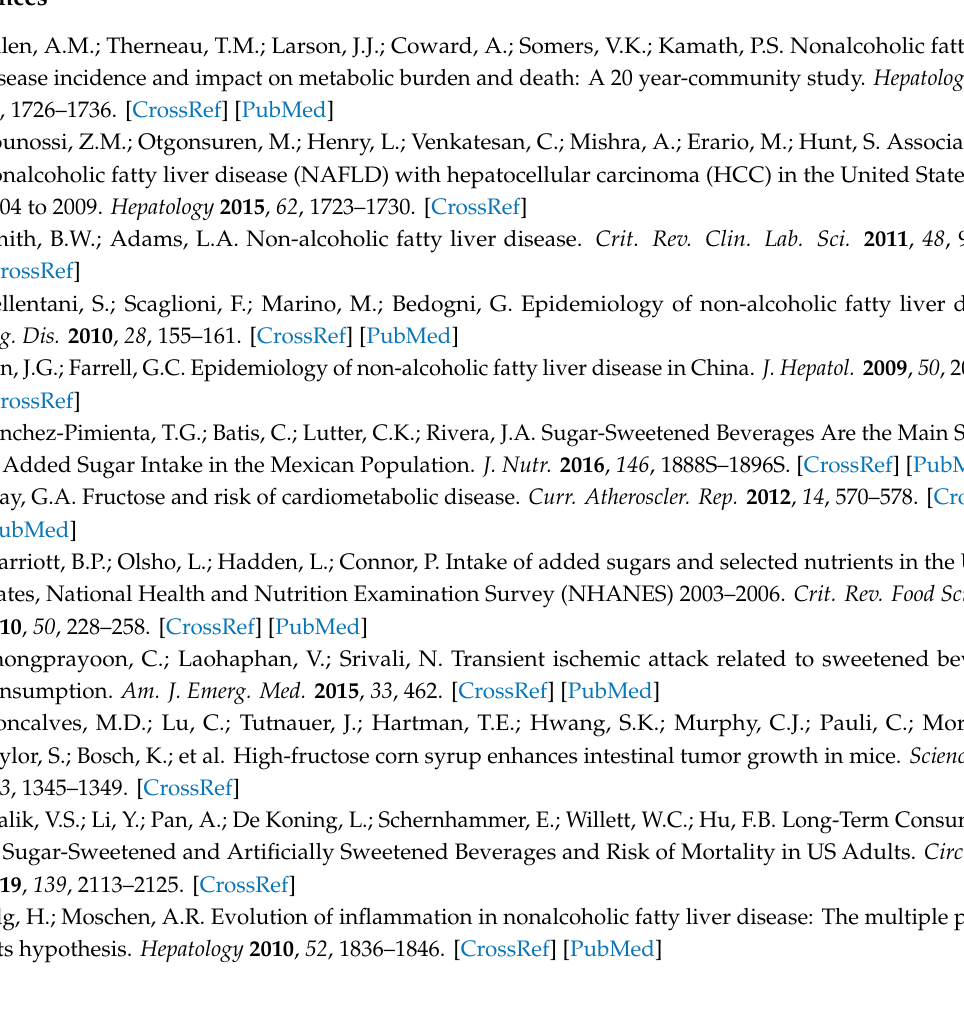
Figure S1: Forest plots showing that the consumption of SSBs significantly increased the risk of NAFLD in both Asian ( p < 0.00001) and non-Asian populations ( p = 0.02), Table S1: Quality assessment of the included studies (Newcastle-Ottawa